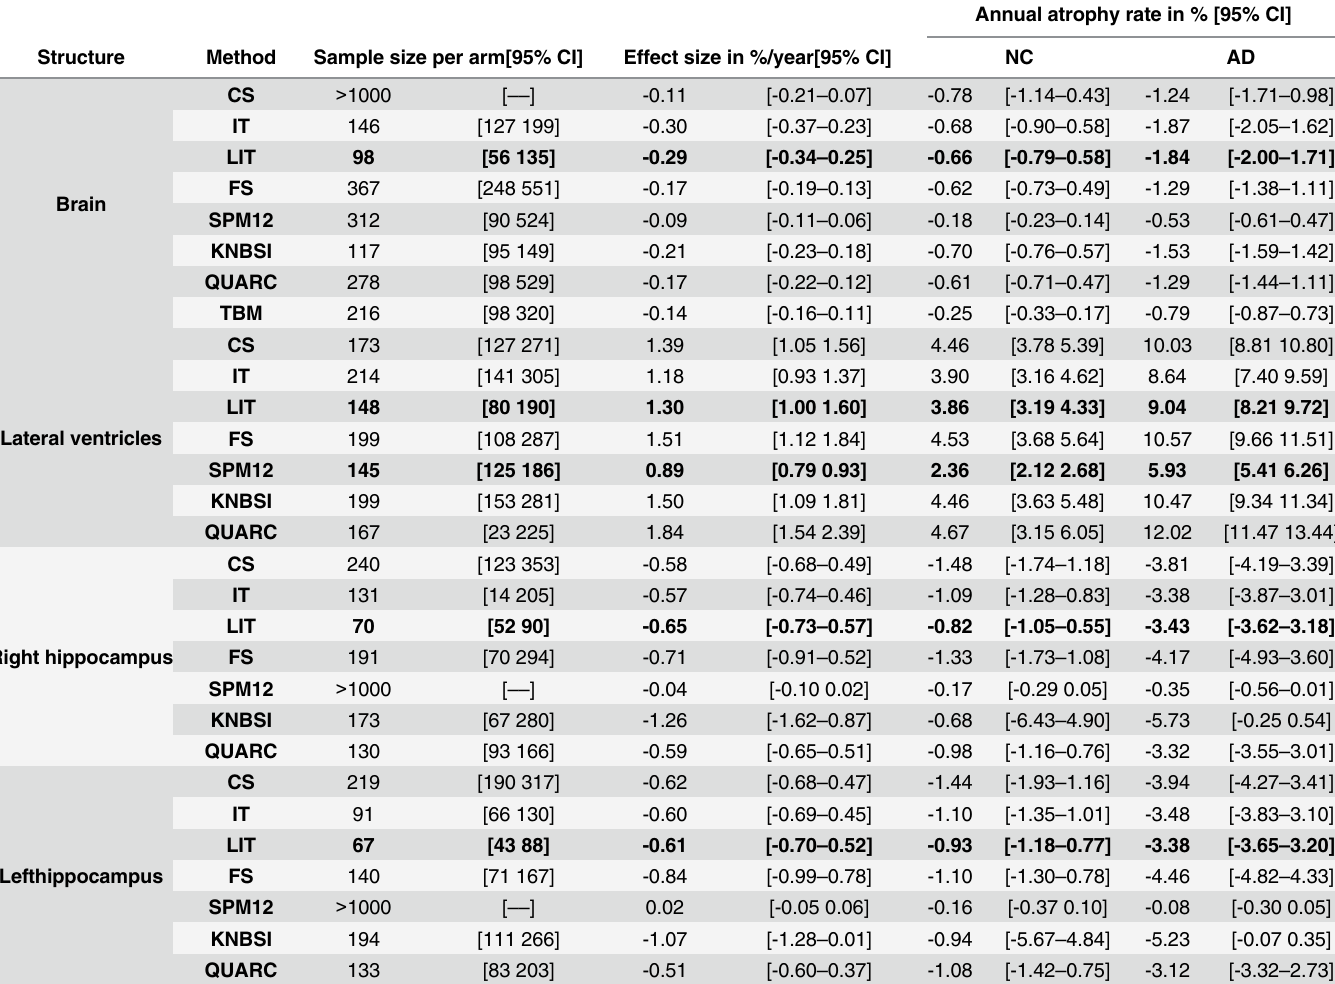
Table 4. Sample size per arm needed to detect a 25% reduction in the annualized rate of brain, ventricular and hippocampus volume change at 80% power for the different methods, while taking into account the normal rate of atrophy. The smallest detectable difference in the rate of change between AD and NC (effect size) and the estimated annual atrophy rate for the different structures for normal controls (NC) and Alzheimer subjects (AD) are also provided with the range representing the 95% confidence interval obtained from parametric bootstrapping of 1000